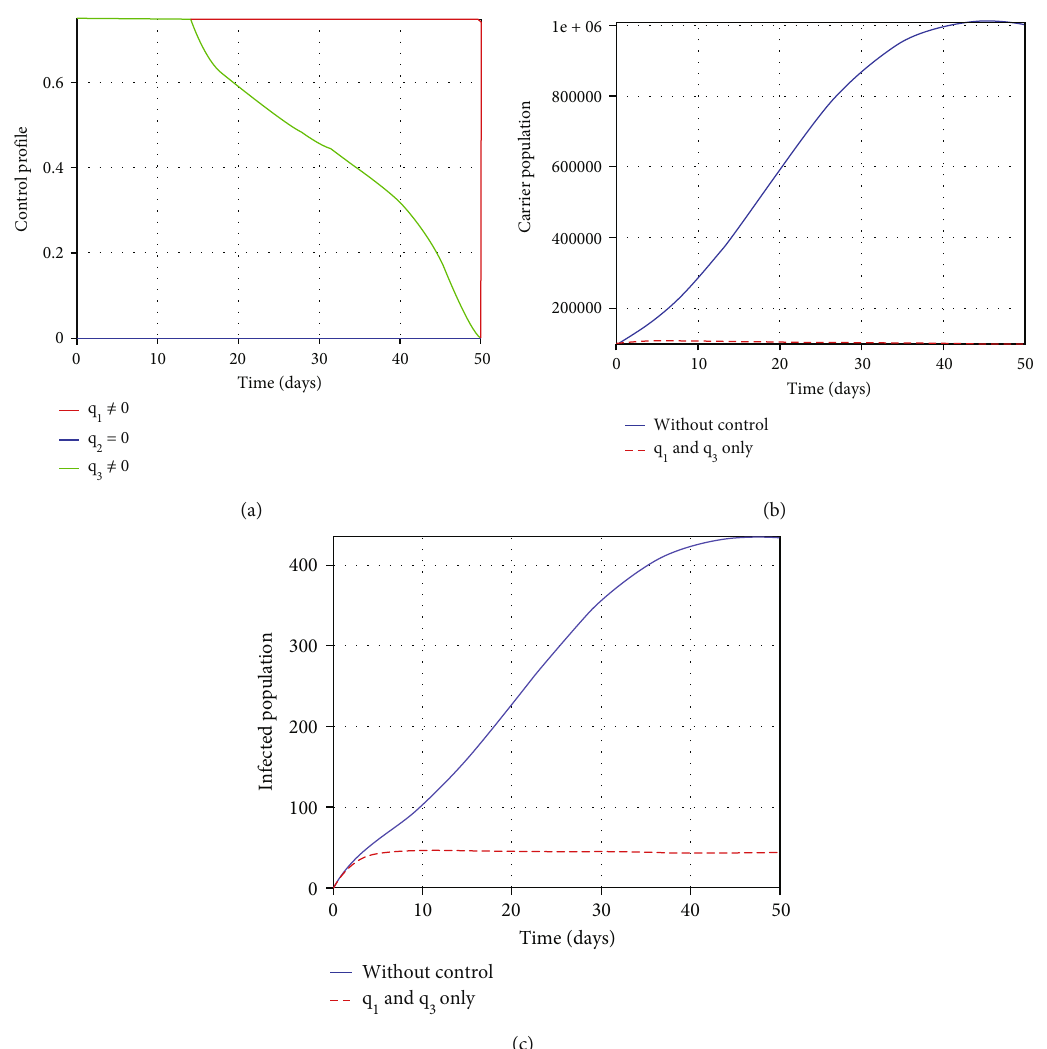
Figure 10: E ff ect of using both vaccination and personal protection only. The simulation results of the control pro fi le in (a) show the e ff ectiveness of this strategy. To eradicate meningitis, vaccination must be administered for all individuals throughout the period while personal protection is encouraged for at least 14 days during the period of infectiousness. The simulation result of the optimal control model shows the e ff ectiveness of these measures on (b) carriers and (c) infected individuals. In the graphs, solid line denotes without control while dotted line indicates implementation of the